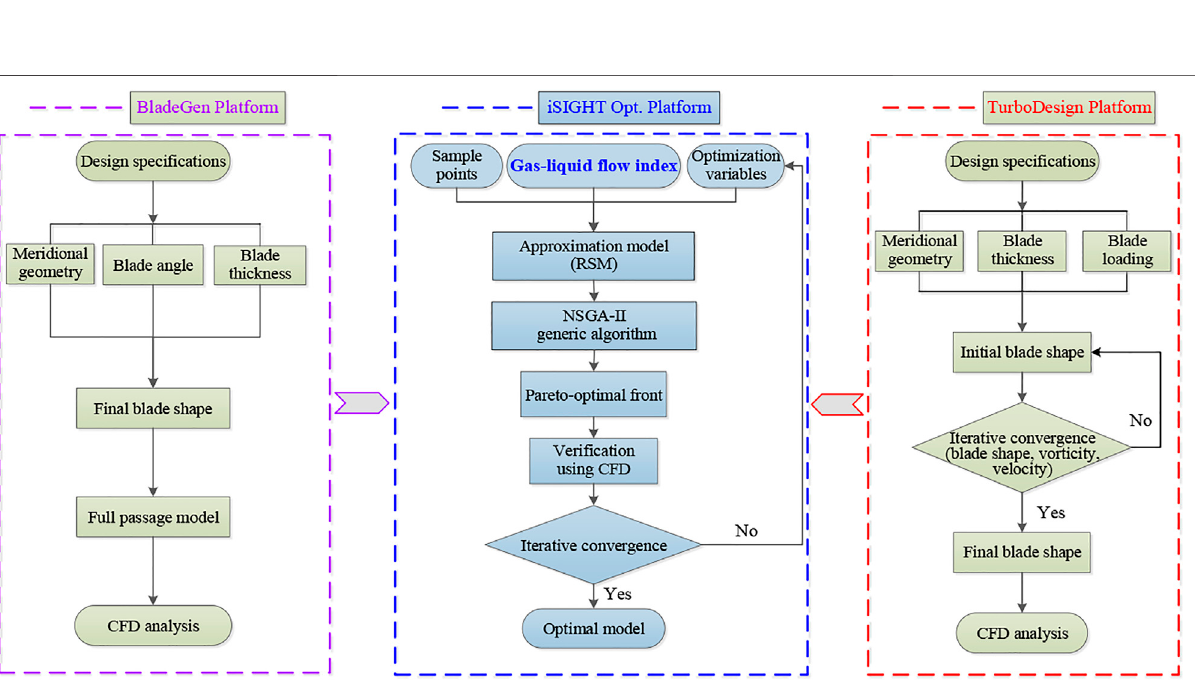
Frontiers in Energy Research |